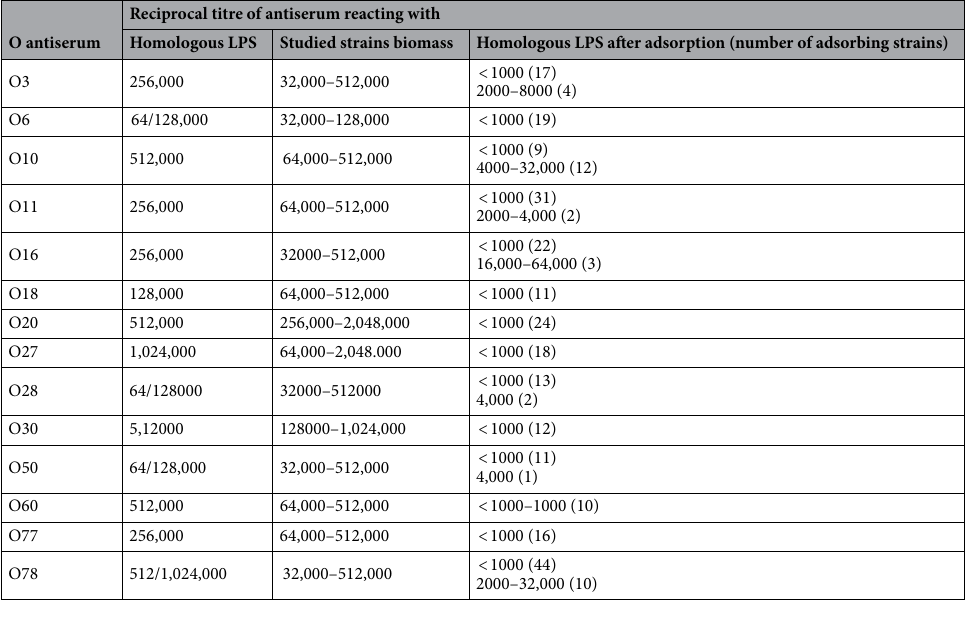
Table 2. Cross reactions of studied strains with the respective O antisera (native and adsorbed by the studied strains’ biomass) in